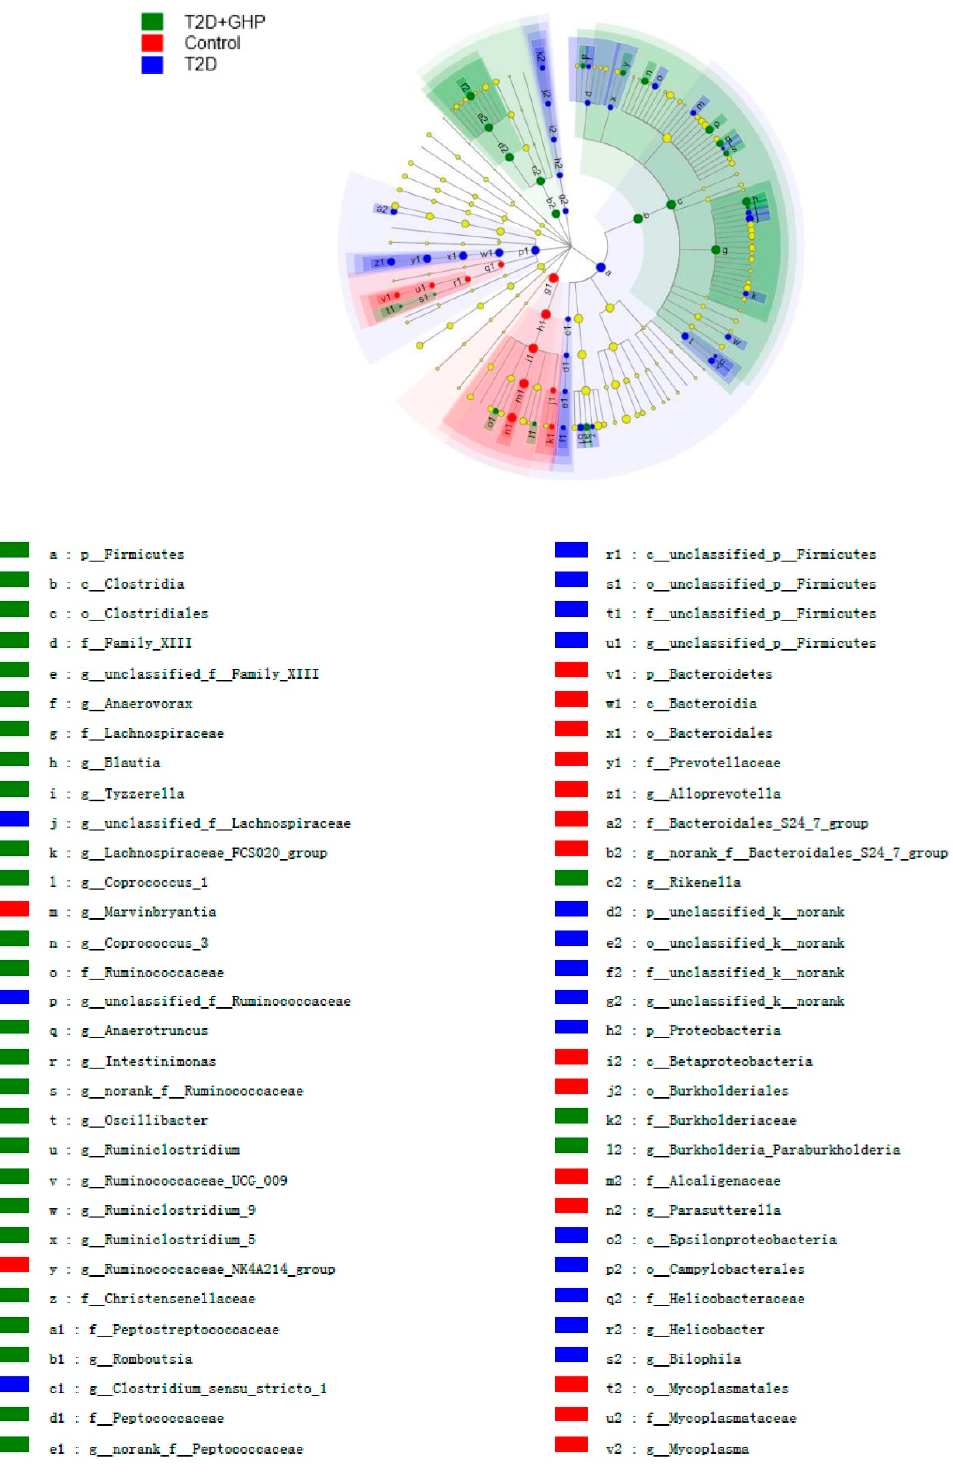
Figure 7. GHP supplementation altered the taxonomic diversity of gut microbiota in T2D mice. Indicator bacteria with LDA scores of 3 or greater are listed. Different color nodes represent microbial groups that are significantly enriched in corresponding groups and have significant changes. Non-significant changes are marked yellow. Each circle is proportional to the abundance of the group. Letters in the figure are noted in the legend.